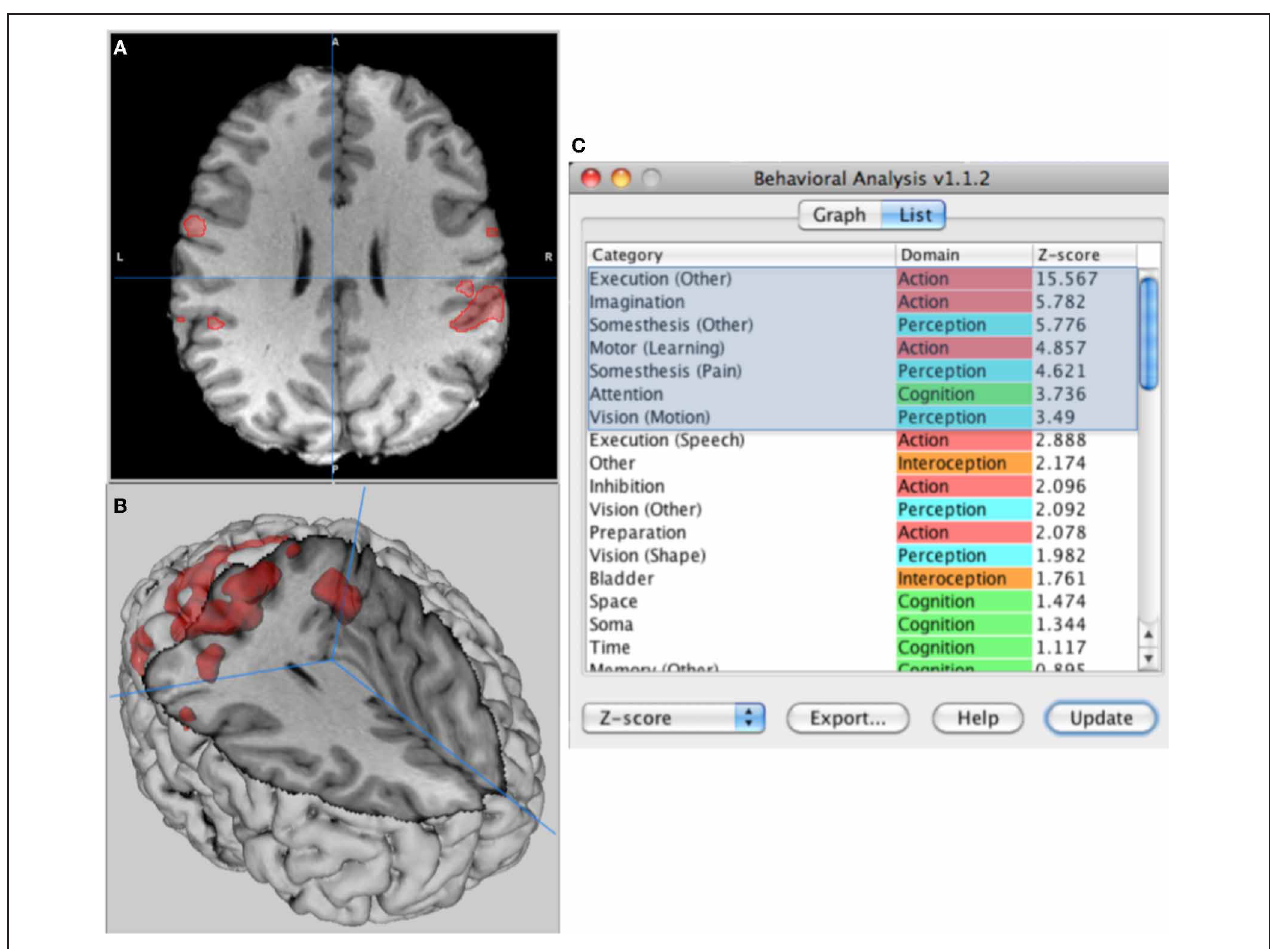
FIGURE 1 | Behavior analysis of left-hand finger tapping. (A) High-resolution brain MRI with ROI from a functional MRI (fMRI) study, (B) surface rendering to illustrate the 3-D nature of the ROI, and (C)